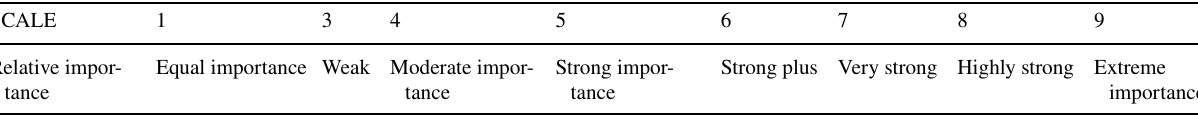
Table 2 Percentage of influencing factor based on Satty’s analytical hierarchical